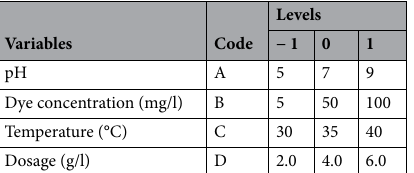
Table 1. The experimental range and levels of input process variables